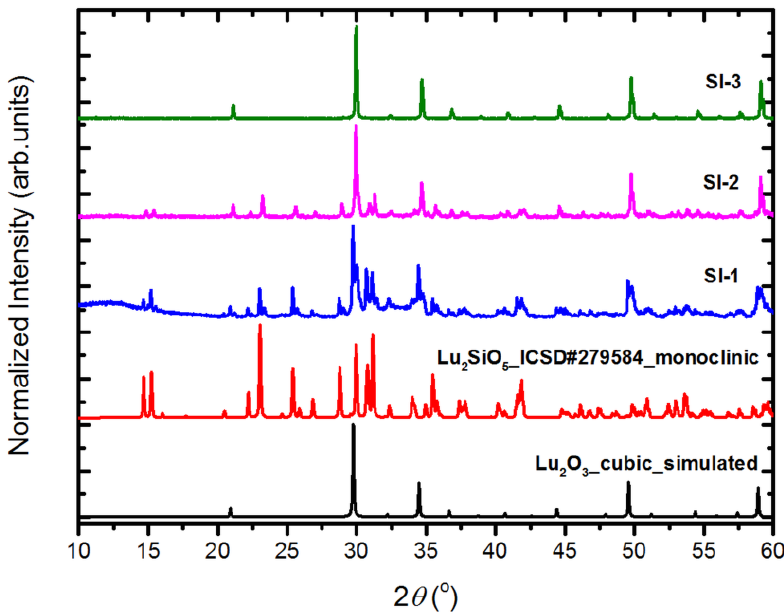
Figure 1. The measured XRD patterns of the powders of Series I: SI-1, SI-2, SI-3, together with simulated pattern of a cubic Lu 2 O 3 (data from this work) and the pattern of a monoclinic Lu 2 SiO 5